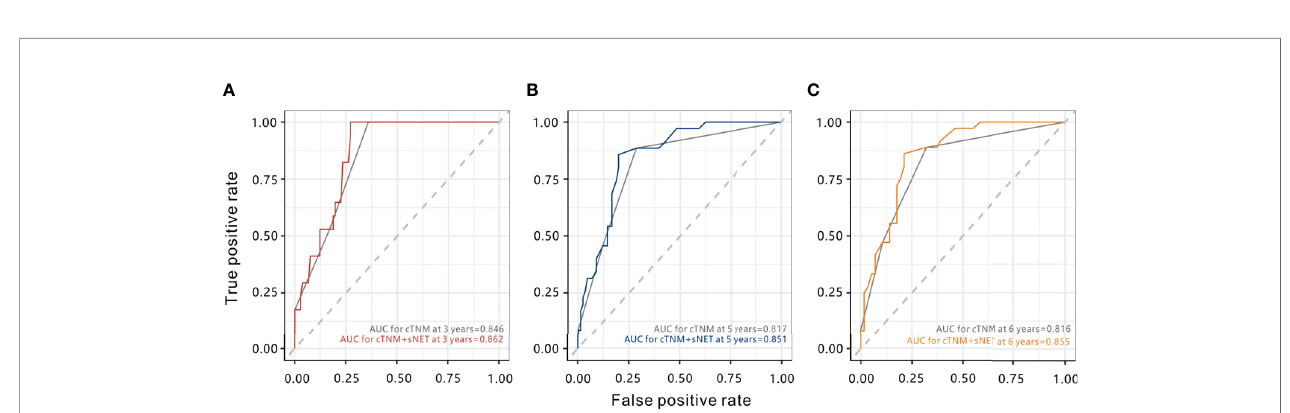
FIGURE 6 | Time-dependent ROC curves to compare the prognostic accuracy of the combination of stromal NETs density and the clinical TNM stage with the clinical TNM stage alone. (A) AUCs at 3 years. (B) AUCs at 5 years. (C) AUCs at 6 years. cTMN, clinical TNM stage. sNET, stromal NET